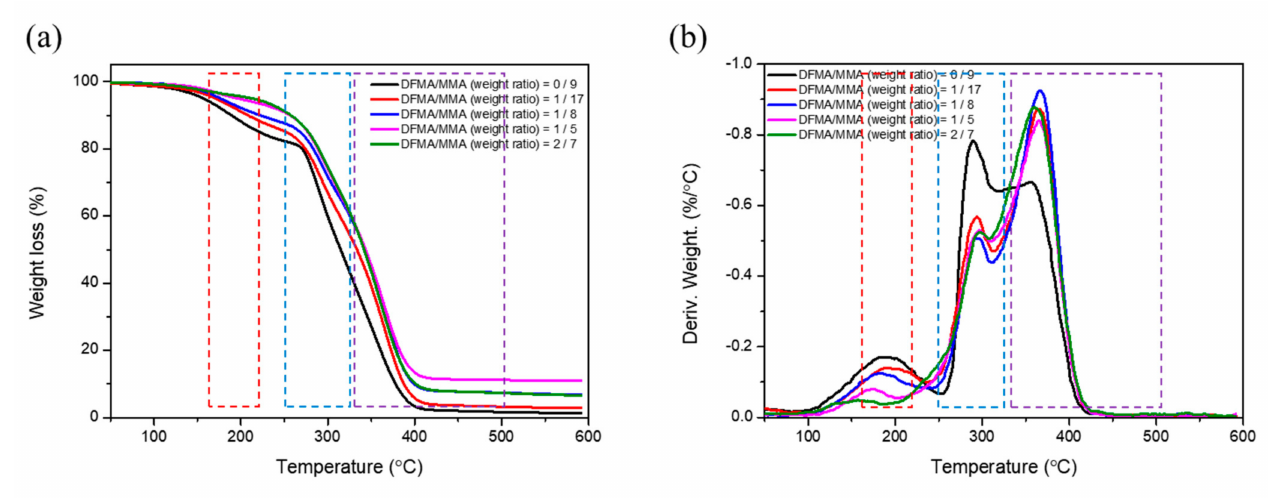
Figure 4. Thermogravimetric analyzer/differential thermal analyzer (TGA/DTA) analyses of the as-prepared nanohybrid silica polyacrylate. ( a ) TGA analysis and ( b ) DTA